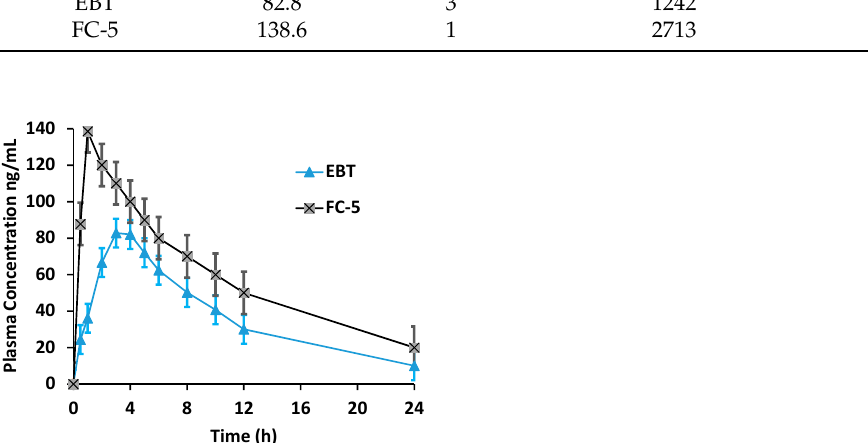
Table 4. Pharmacokinetic parameters after oral administration of pure EBT and FC-5 orodispersible films ( n = 6). Formulations